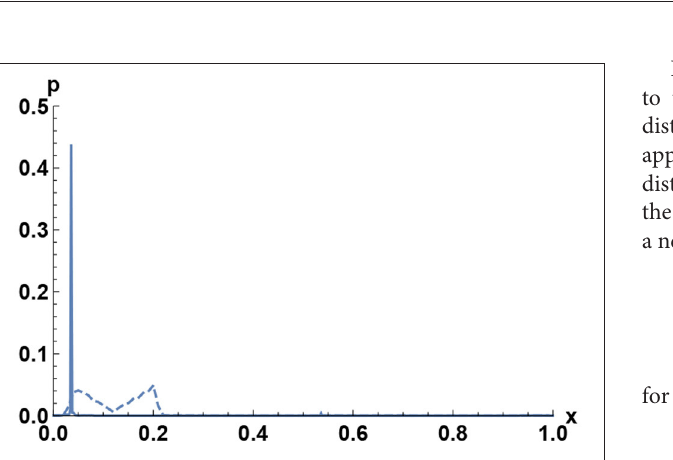
FIGURE 2 | The numerical results for probability distribution of x = α/ (2 π ). The smooth line is ρ 0 ( x ), the dashed line ρ 1 ( x ). (Left) q 01 = q 10 = 0.015, and (Right) q 01 = q 10 = 0.020.